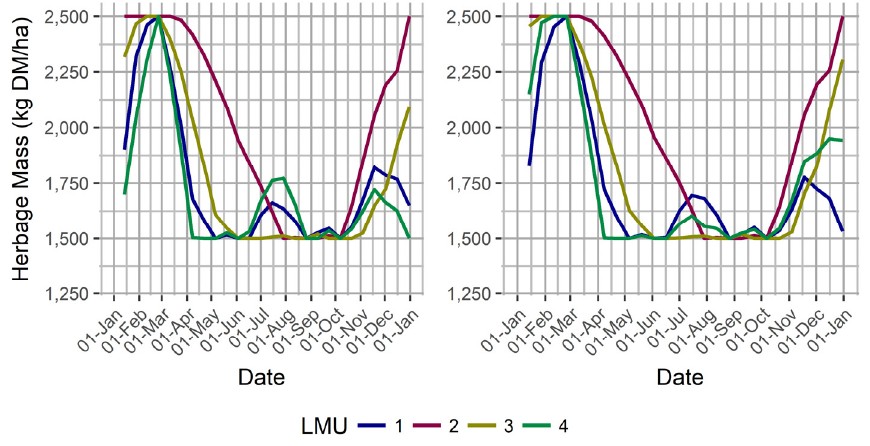
Figure 4. Modelled herbage mass for the farm-level case (Base farm) ( left ) and farm-level case (Fecund farm) ( right ) on each of the four LMUs over 12 months.